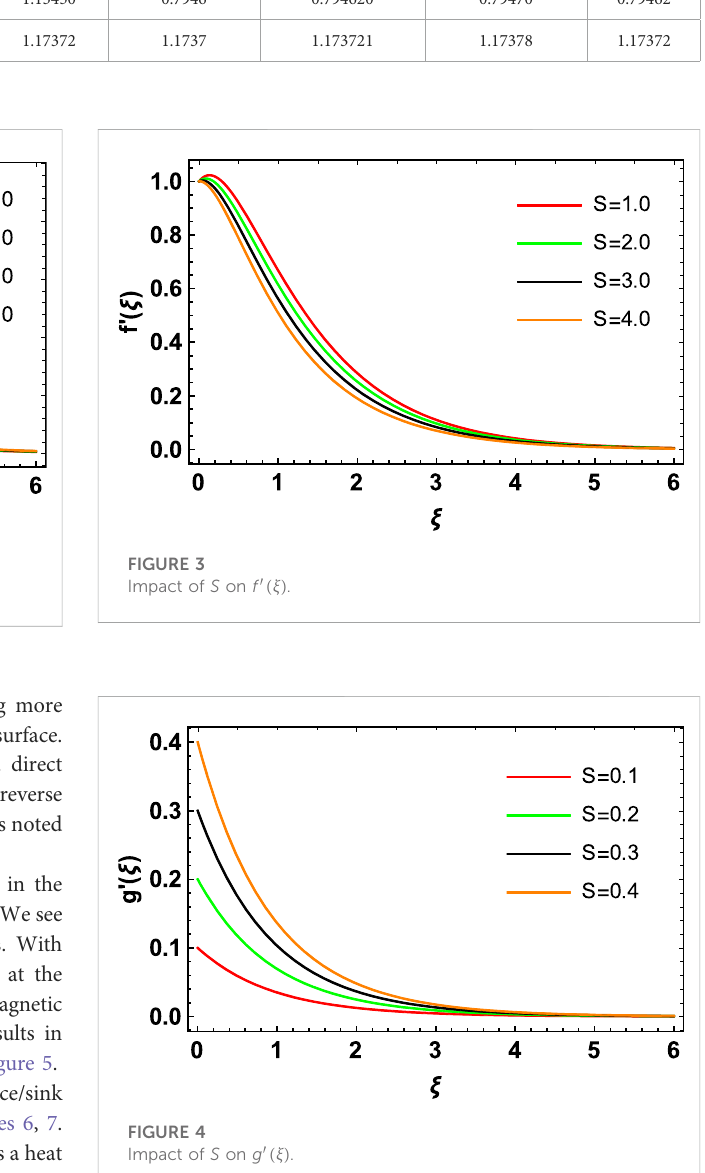
FIGURE 4 Impact of S on g ′ ( ξ )